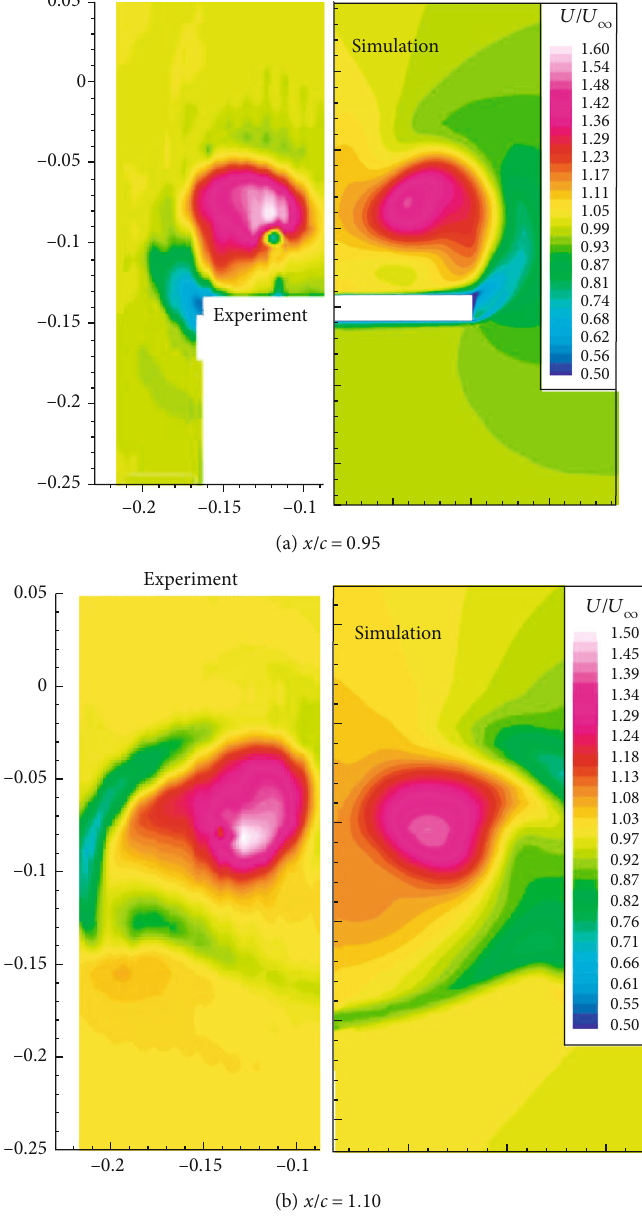
Figure 5: The axial velocity distribution from experiments and simulation, case